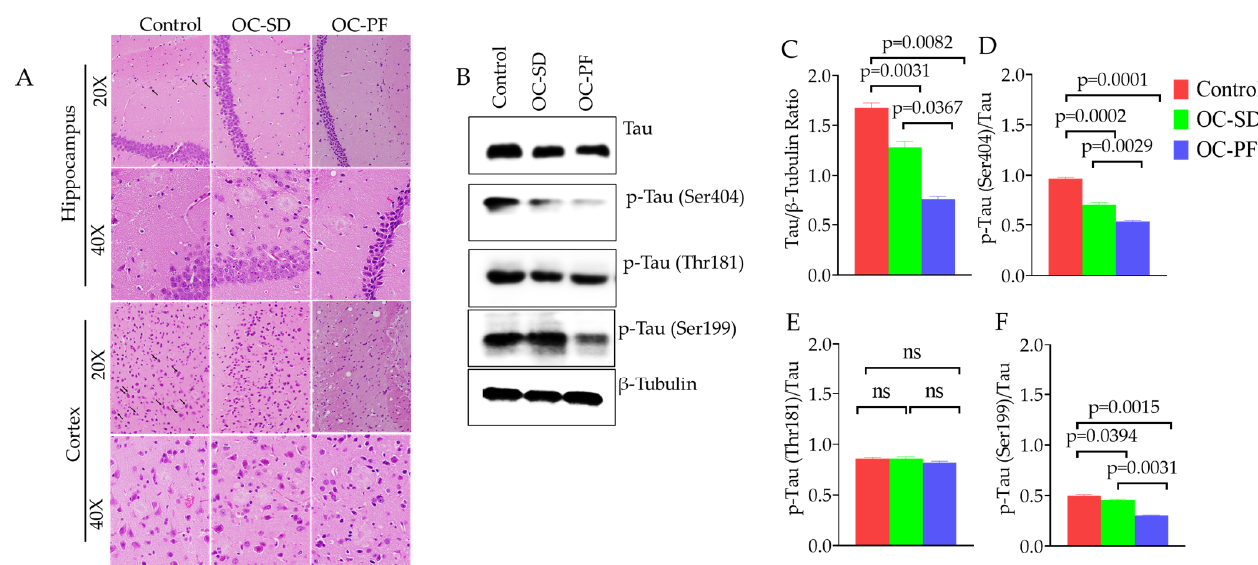
Figure 6. Effects of OC-PF and OC-SD treatments on tau phosphorylation in 5xFAD mouse brains. ( A ) Representative 5xFAD mouse brain cortex and hippocampus sections stained with H&E. ( B ) OC-PF and OC-SD treatments effect on the levels of total and tau phosphorylation at amino acid residues Ser404, Thr181, and Ser199 in 5xFAD female mice brain homogenates. ( C – F ) Scanning densitometric analysis of blots for total tau (F (2, 6) = 89.74, p < 0.05), p-Tau (Ser404) (F (2, 6) = 15.3, p < 0.05), p-Tau (Thr181) (ns), and p-Tau (Ser199) (F (2, 6) = 36.90, p < 0.05), respectively. Scanning densitometry was obtained for each blot, carried out in triplicate and the integrated optical density of each band was normalized with the corresponding density found for β-tubulin in the same blot. Data are presented as mean ± SEM. Statistical analysis was determined by one-way analysis of variance (ANOVA) followed by post-hoc analysis by Tukey’s test; p < 0.05 was considered statistically significant, n = 6 mice/group. “ns”: non-significant.